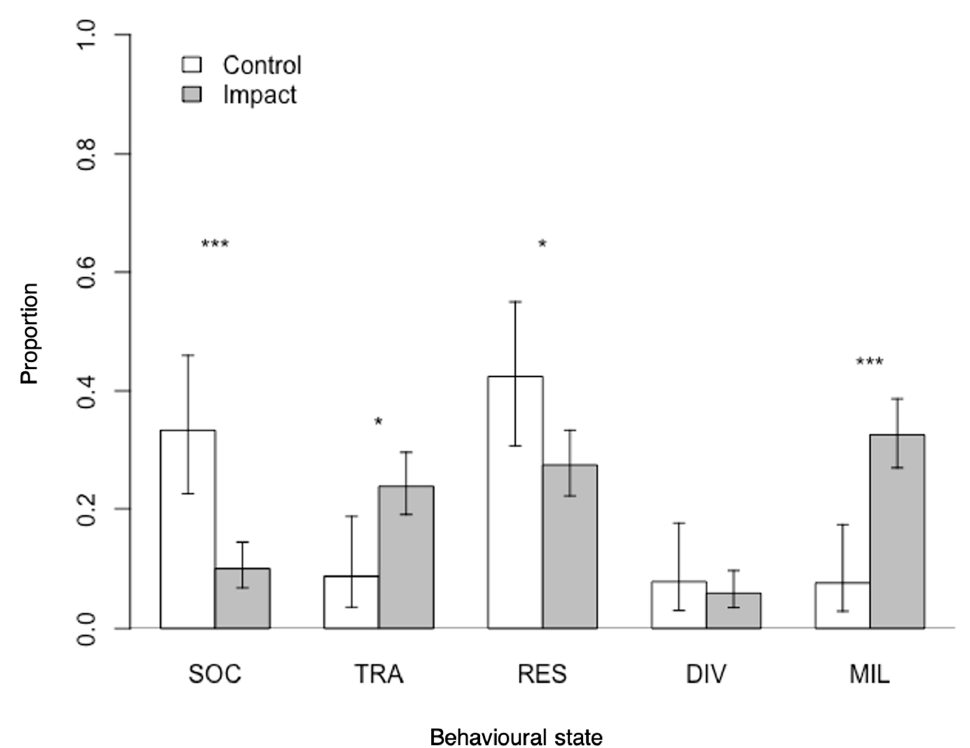
Figure 3. Behavioural budget proportions of spinner dolphins in the presence (impact) and absence (control) of dolphin- watching vessels. Error bars represent 95% confidence intervals. Significant differences are indicated with an asterisk (* p < 0.05, *** p < 0.001). SOC: socialising; TRA: travelling; RES: resting; DIV: diving; MIL: milling.